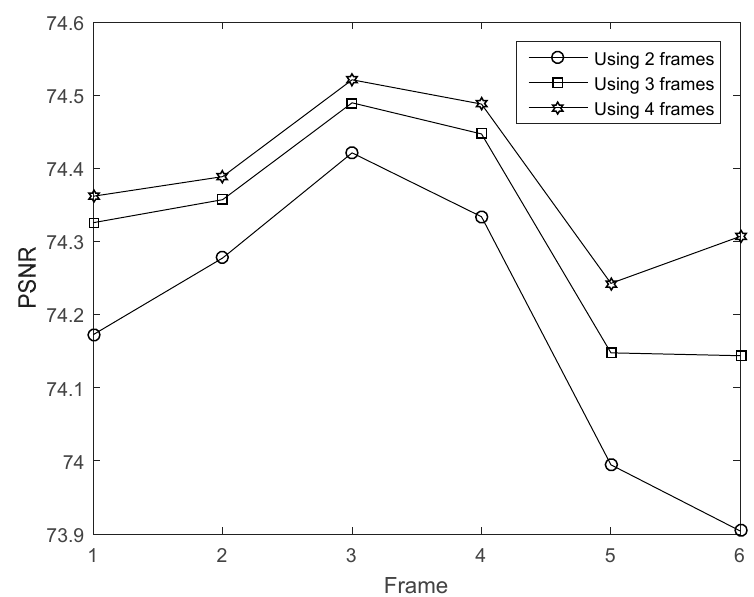
Figure 8. PSNR of the image recovered using 2, 3 and 4 frames for multi-frame motion estimation.